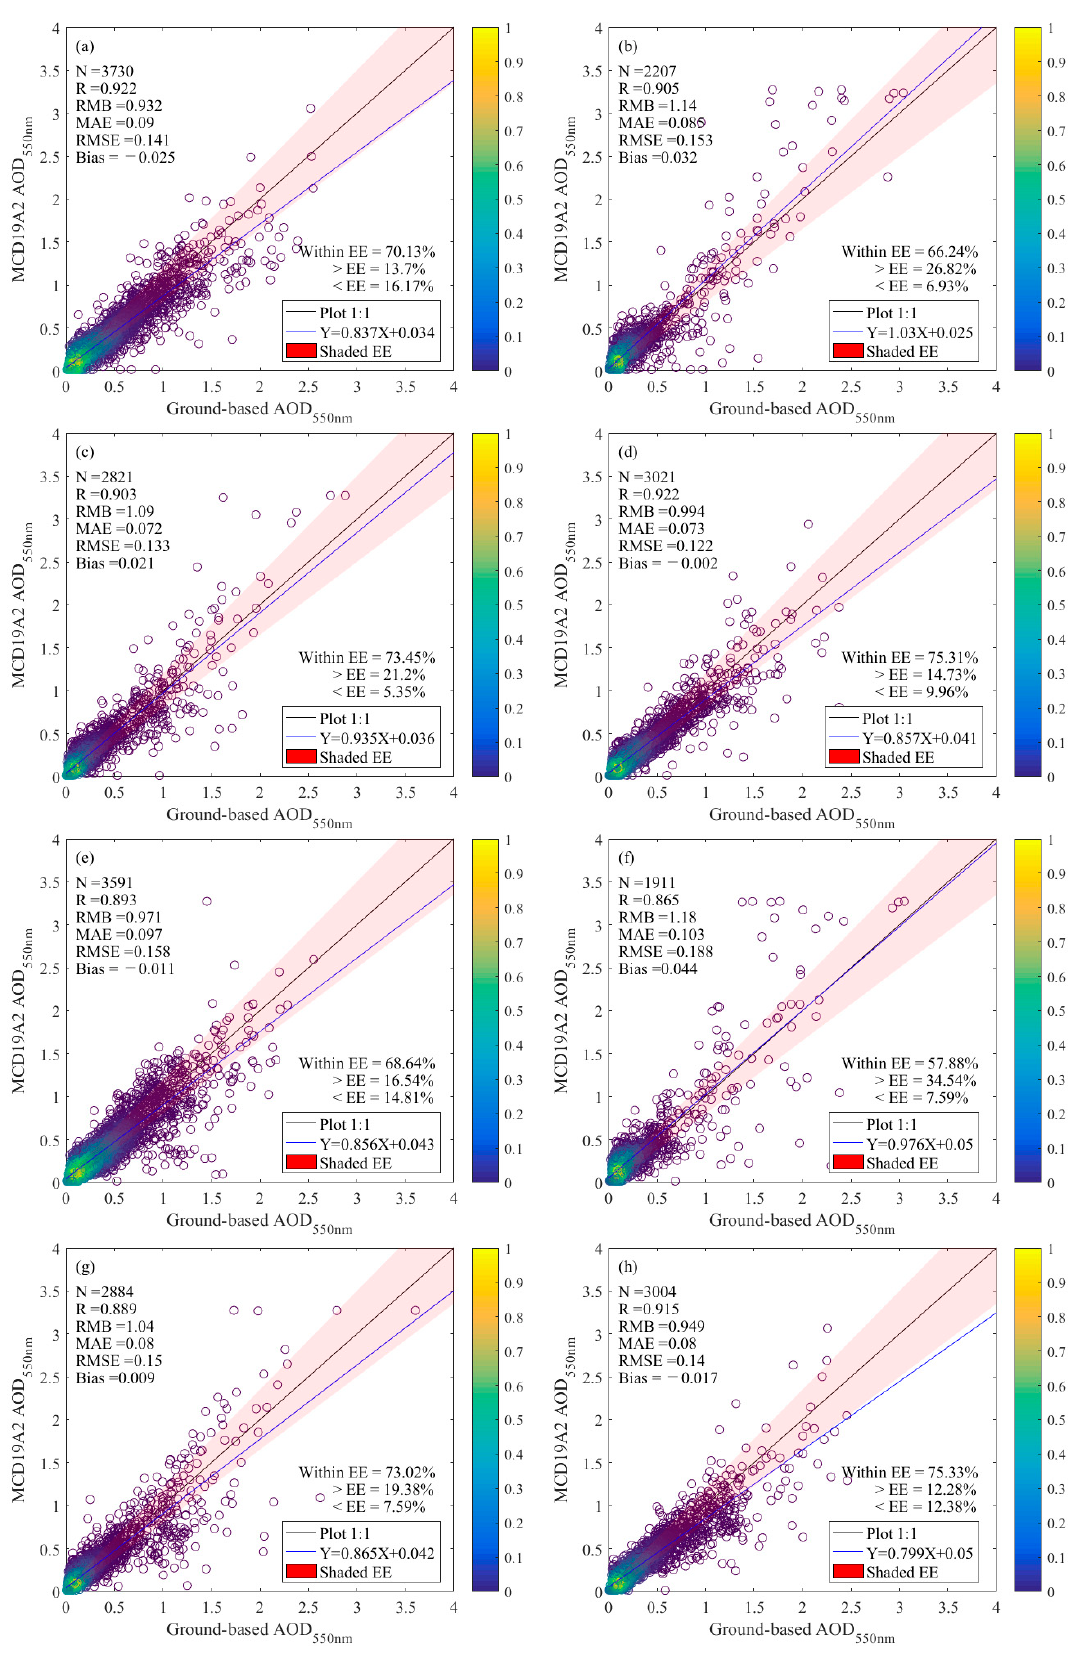
Figure 4. Comparison of the accuracy of AOD observations for MAIAC Terra ( a – d ) and Aqua ( e – h ) against AERONET measurements in ( a , e ) spring; ( b , f ) summer; ( c , g ) autumn and ( d , h ) winter.